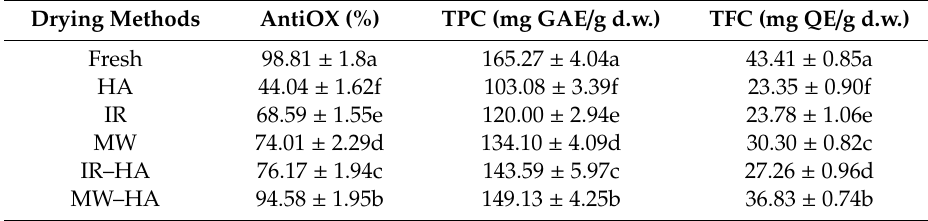
Table 8. Results of AntiOXs, TPC, and TFC of terebinth samples under di ff erent drying